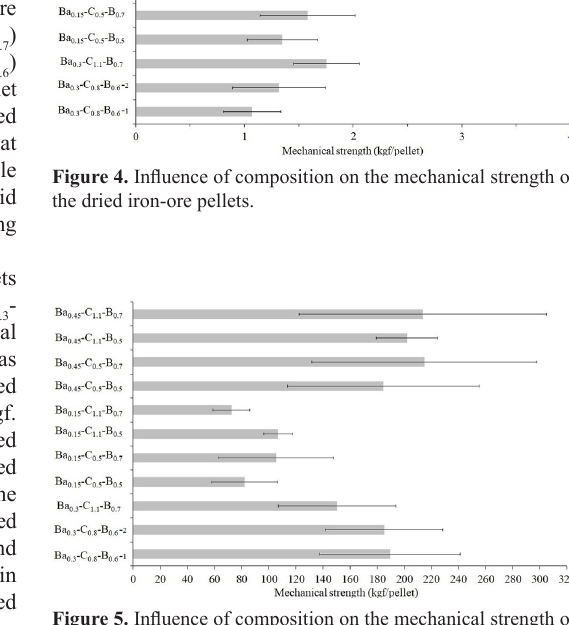
Figure 5. Influence of composition on the mechanical strength of the fired iron-ore